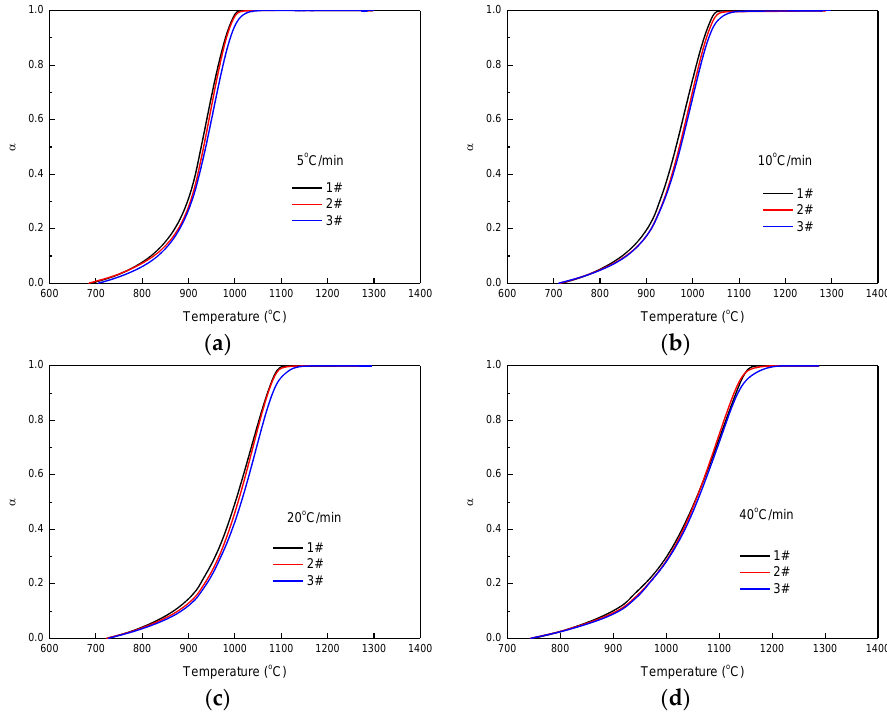
Figure 4. The gasification conversion factor for coal samples with di ff erent particle sizes: ( a ) 5 K / min, ( b ) 10 K / min, ( c ) 20 K / min, and ( d ) 40 K / min. Energies 2020 , 13 , x FOR PEER REVIEW 7 of 10